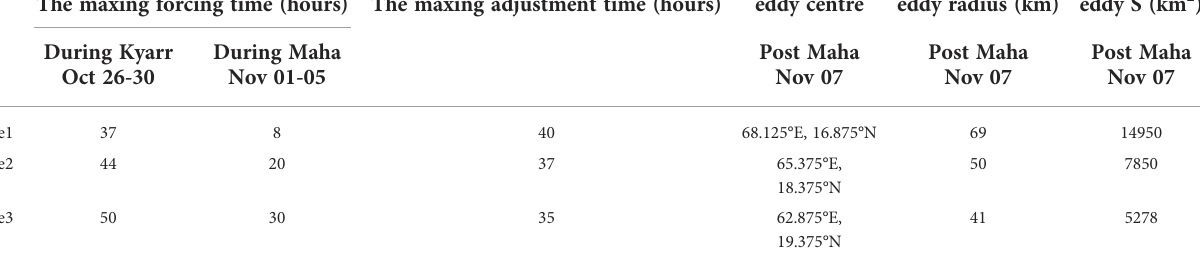
TABLE 2 Information about cyclonic eddies identi fi ed by eddy detection algorithms.